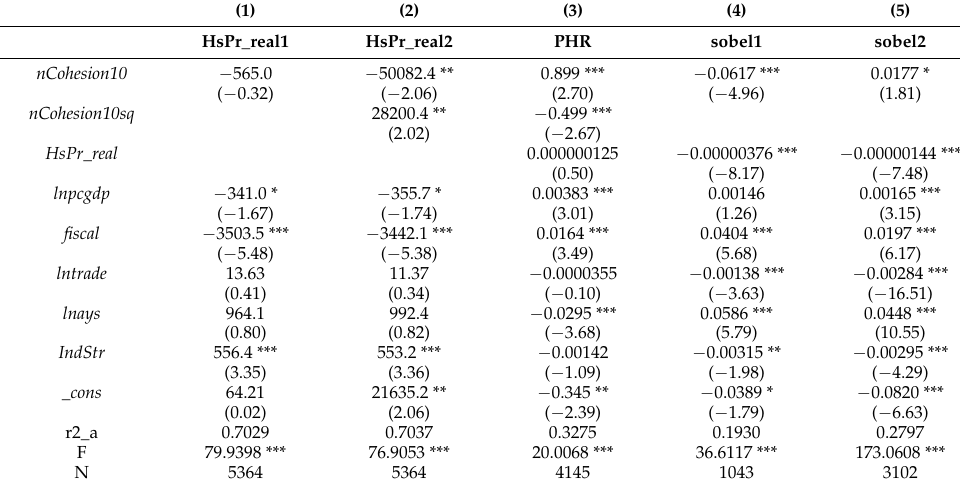
Table 5. Mechanism tests: impact of city shape on housing prices.